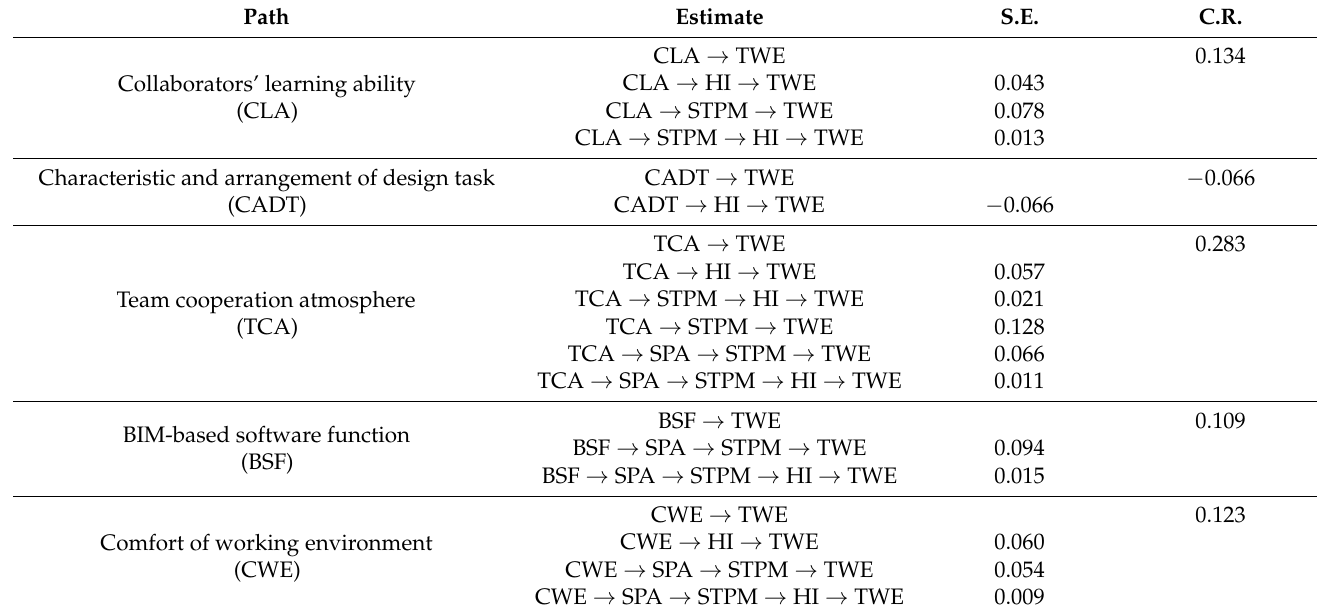
Table 9. Total effect of influencing factors on TWE in the final